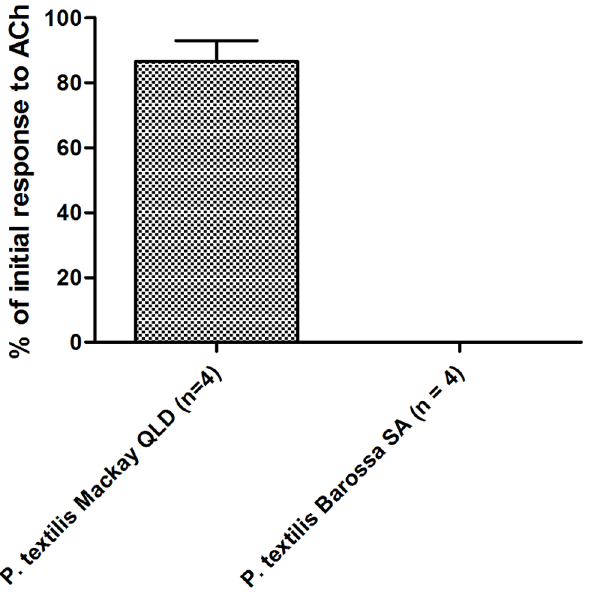
Figure 2. Response to exogenous acetylcholine in the chick biventer cervicis nerve-muscle preparation. 2 hours after exposure to 10 m g/ml venom (vehicle: water).